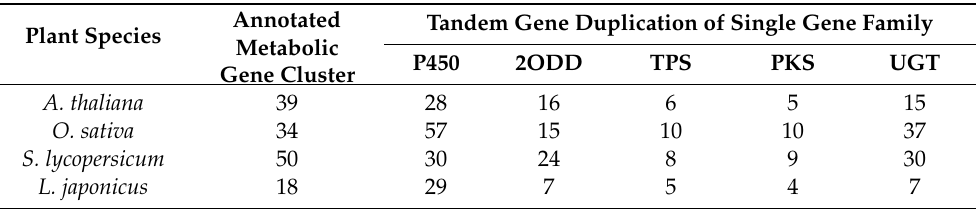
Table 1. Genomic survey for prediction of the metabolic gene clusters and neo-functionalization. Plant Species